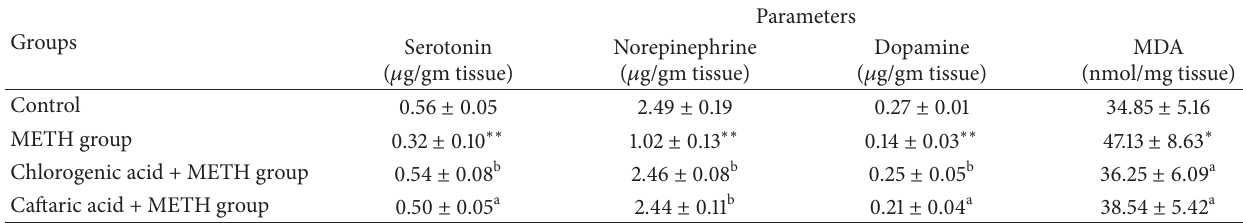
Table 6: Effect of chlorogenic and caftaric acids on serotonin, norepinephrine, dopamine, and MDA in the brain cerebral cortex of METH- injected rats.